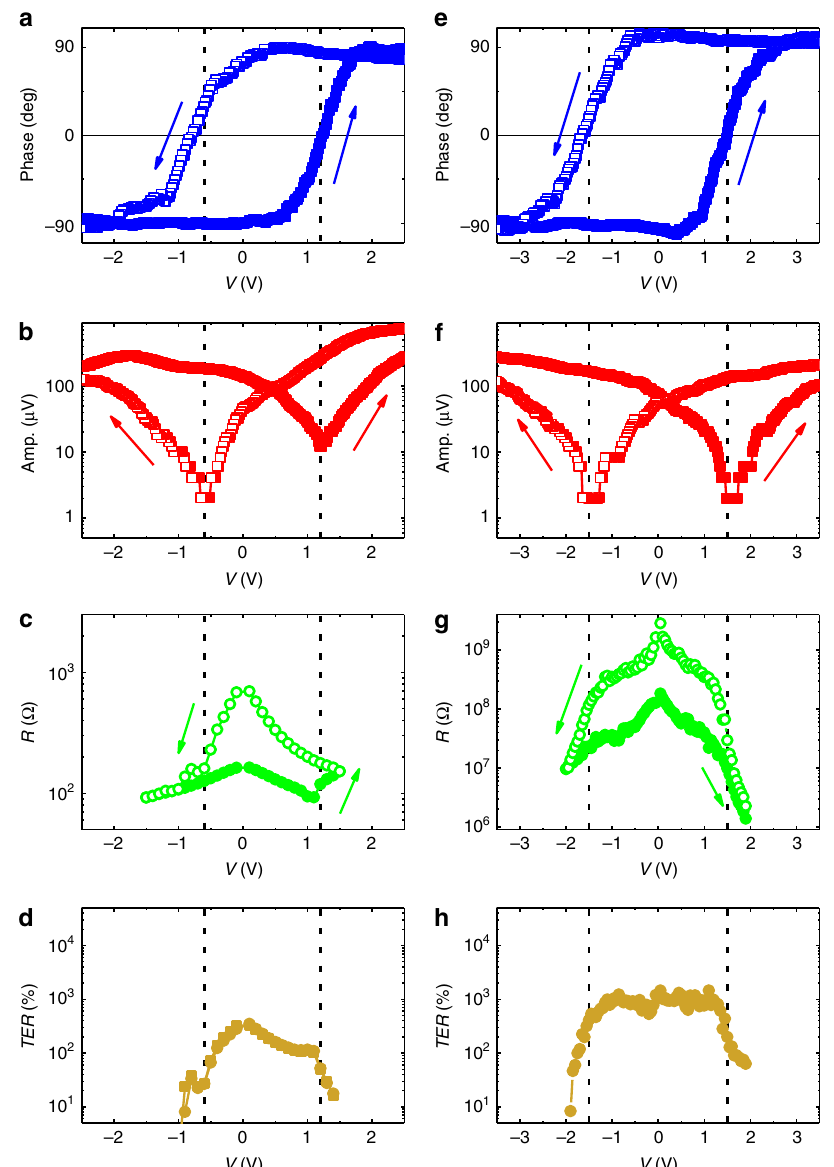
Figure 3 | Polarisation-induced resistance switching in PVDF tunnel junctions. ( a ) Local PFM phase and ( b ) amplitude versus voltage on a 1L PVDF film deposited on Au-coated Si substrates. ( c , d ) Voltage dependences of the resistance and TER of a Au/PVDF (1L)/W junction, respectively. ( e ) Local PFM phase and ( f ) amplitude versus voltage on a 2Ls PVDF film deposited on Au-coated Si substrates. ( g , h ) Voltage dependences of the resistance and TER of a Au/PVDF (2Ls)/W tunnel junction, respectively. The vertical dashed lines show the agreement between polarisation and resistance coercive voltages. reversal in all four junctions: when the polarisation switches from Fig. 4b,f; junction #2, Fig. 4c,g) and two different 2Ls PVDF downward to upward, ^ 1 increases while ^ 2 decreases, and vice junctions (junction #3, Fig. 4d,h; junction #4, Fig. 4e,i). The I–V versa. The electron potentials decrease along the direction of the curves are fitted using a direct electron tunnelling model through ferroelectric polarisations as expected within the framework of a trapezoidal tunnel barrier 10,31 . We consider that the barrier has electrostatic models based on partial electrode screening of a width d (defined as the thickness of the PVDF film), and that polarisation charges 12,13 . Moreover, the polarisation-induced the electron barrier heights are ^ 1 at the PVDF/W interface or ^ 2 at the Au/PVDF interface (Supplementary Note 2). Transport variation of ^ 1 is smaller than ^ 2 (Supplementary Table 1) in measurements can be accurately reproduced by the model for agreement with the lower screening length for W ( B 0.048 nm) both polarisation orientations (solid lines in Fig. 4b–e for (ref. 32) than for Au ( B 0.07 nm) (ref. 8). Such variations of downward polarisation, and in Fig. 4f–i for upward potential profiles with polarisation give an estimate of PVDF polarisation) considering a constant effective mass for ferroelectric polarisation of 8–18 m C cm (cid:3) 2 (Supplementary Table 1) in agreement with polarisation measurements 25 and tunnelling electrons of m * ¼ 0.12 m 0 . The electron potential profiles resulting from the fits are displayed in Fig. 4j–m (orange calculations 33 . Finally, we conclude that the modulation of tunnel and brown for downward and upward polarisation, respectively). transmission through variations of the potential barrier shape is The interfacial barrier heights vary similarly with polarisation responsible for TER in these PVDF-based FTJs. NATURE COMMUNICATIONS|7:11502|DOI: